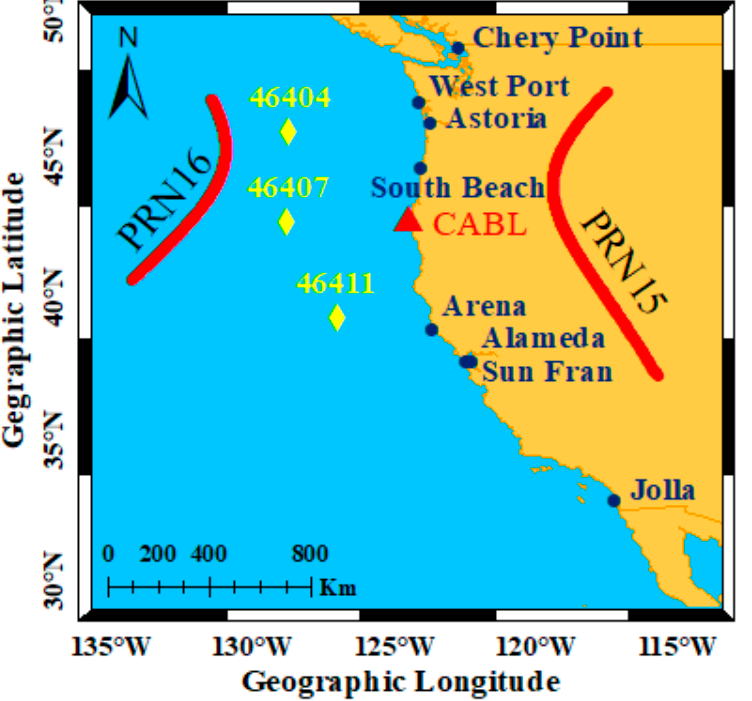
Figure 11. Spatial distribution of DART (yellow diamond), tide gauge stations (dark-blue circle), GPS station CABL (red triangle), and location of IPPs for PRN15 and PRN16 observed from GPS station CABL on 11 March 2011.